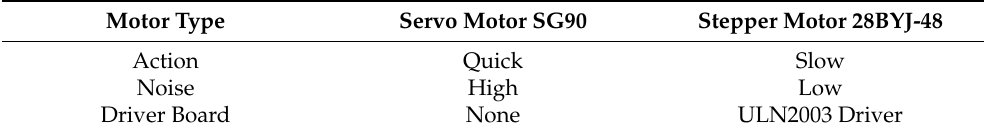
Table 1. Advantages and disadvantages of motor types.